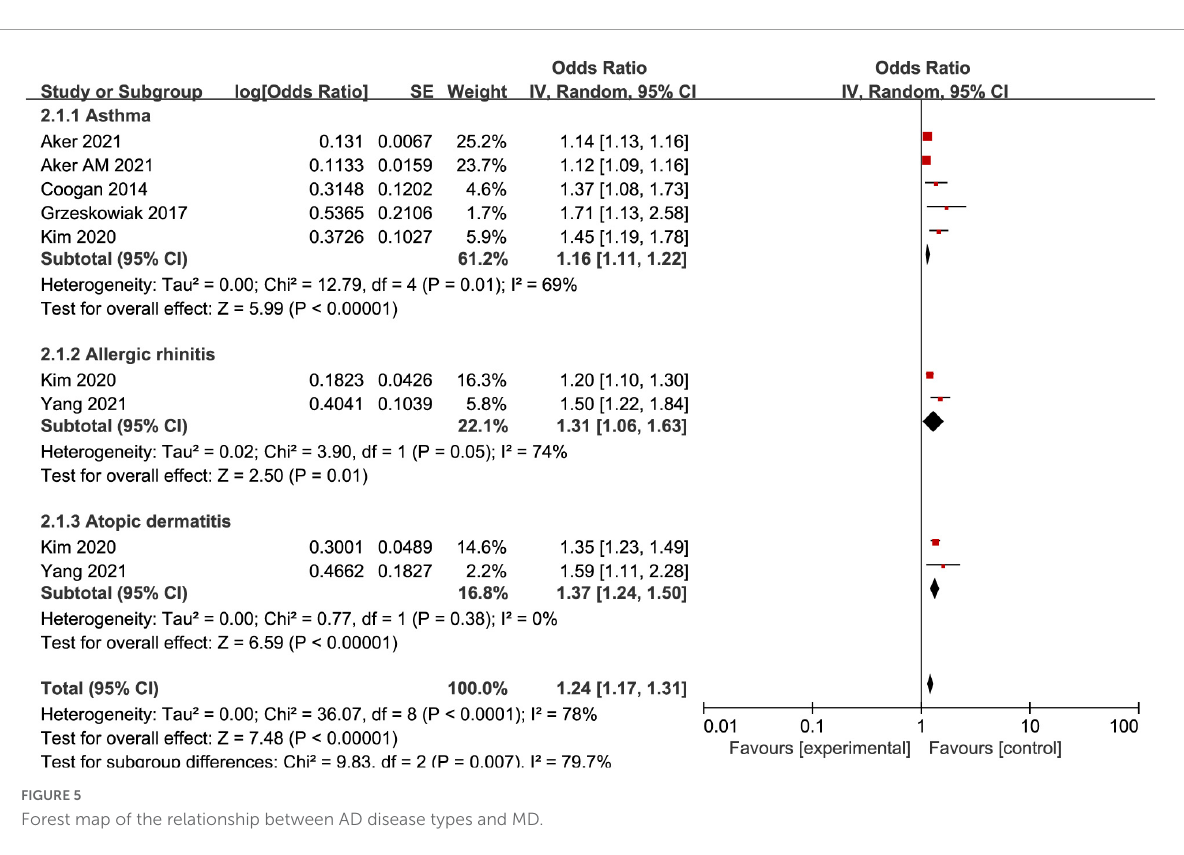
FIGURE5 Forest map of the relationship between AD disease types and MD.